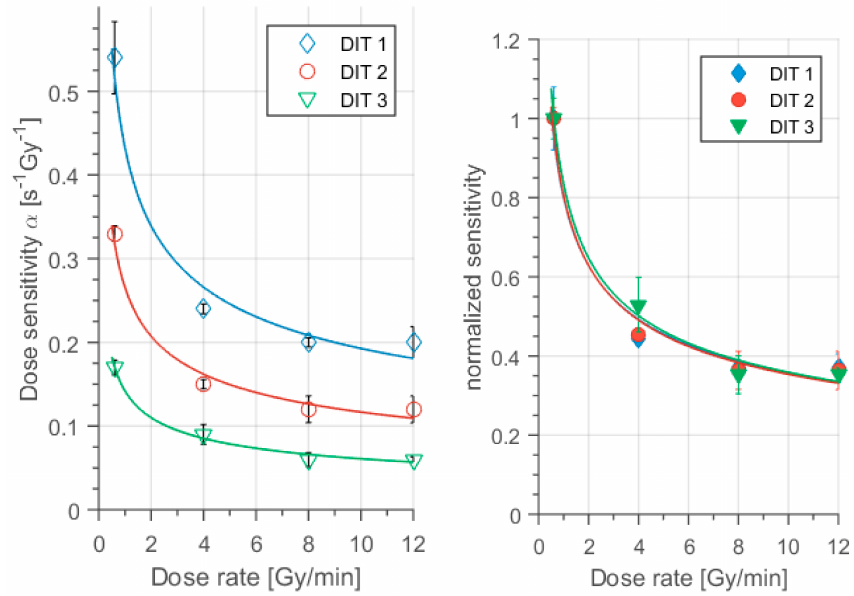
Figure 9. Dependence of the sensitivity of Dithiothreitol and Methacrylic Acid (MAGADIT) on the dose rate. Reproduced from